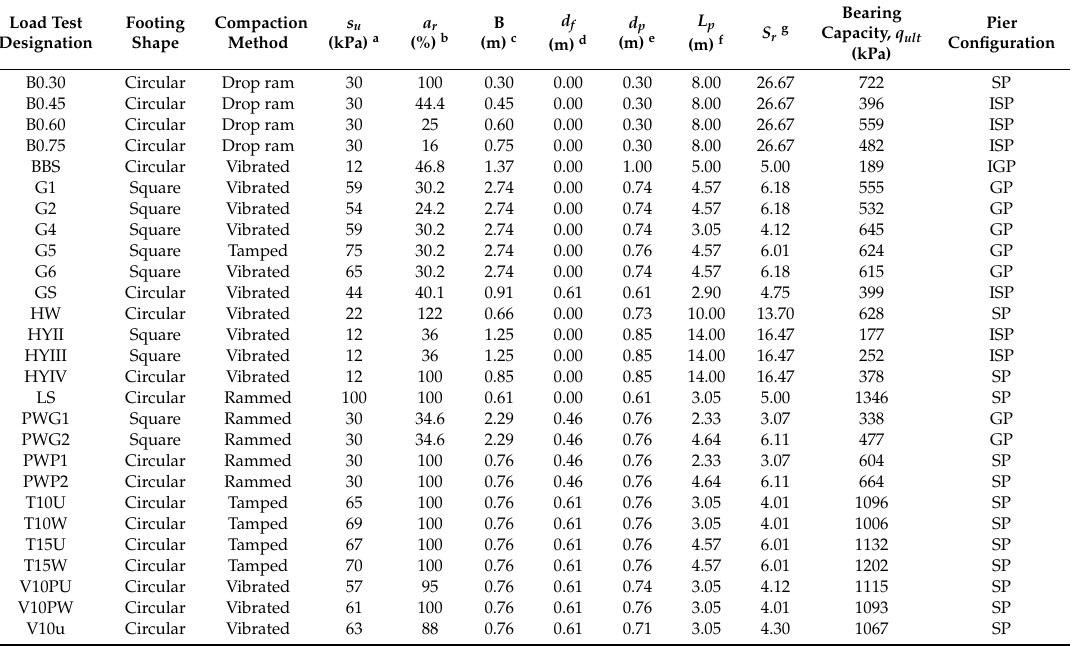
Table 1. Summary of footing load test